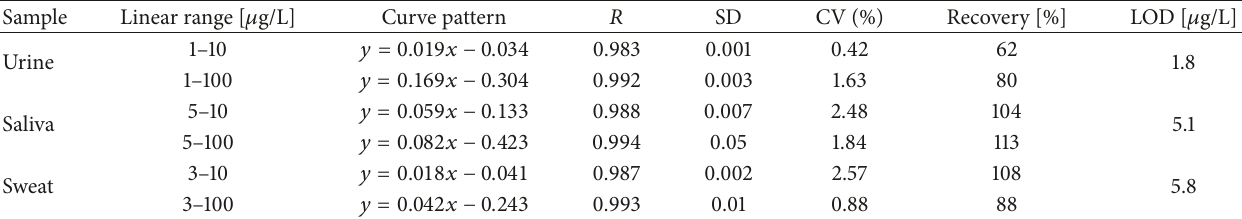
Figure 6: Examples of chromatograms of tested smoker’s urine (12.45 𝜇 g CN − /L) and saliva (7.37 𝜇 g CN − /L) and nonsmoker’s sweat ( < LOD) samples. Table 1: Parameters of the IC-PAD method for the determination of cyanide